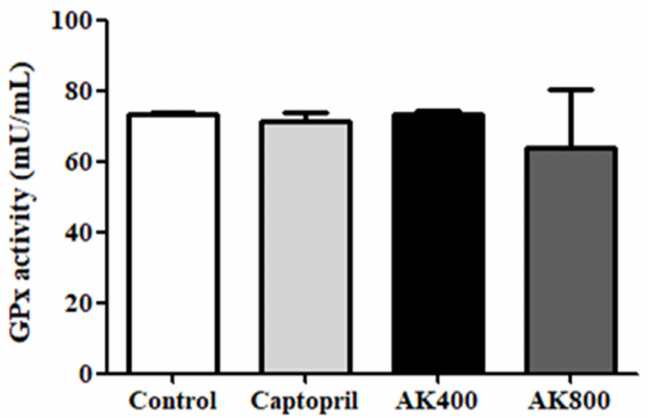
Figure 5. Glutathione peroxidase (GPx) activity in the SHR brains. The groups are the control (distilled water), captopril (20 mg / kg body weight), AK3K400 (400 mg / kg body weight), and AK3K800 (800 mg / kg body weight). Data are presented as mean ±